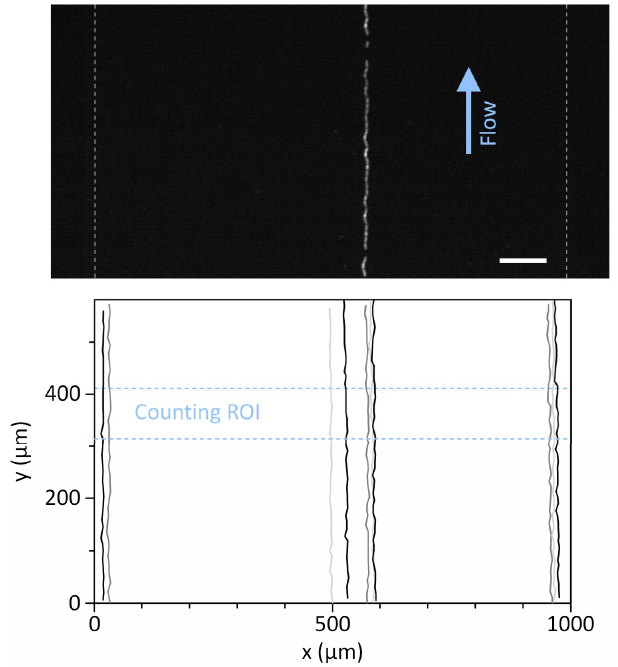
Figure 5. Effect of pumping vibration on cell imaging using the miniature fluorescence microscope. The top and bottom panels show the overlaid fluorescence trajectory of a single WBC and the trajectory plot of 10 independent WBCs, respectively. Single cells were traced through the imaging area by measuring and overlapping their positions in the x-y plane over time. The vibration was generated mainly in the x -axis direction, so that the imaged cells appeared to be slightly shaken. However, there was no significant change in the z -axis focus of the imaged cells. Scale bar, 100 µ m.